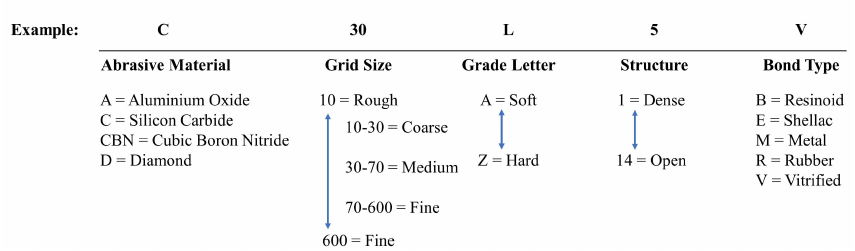
Figure 2. Example manufacturer coding for grinding wheel C30LV and